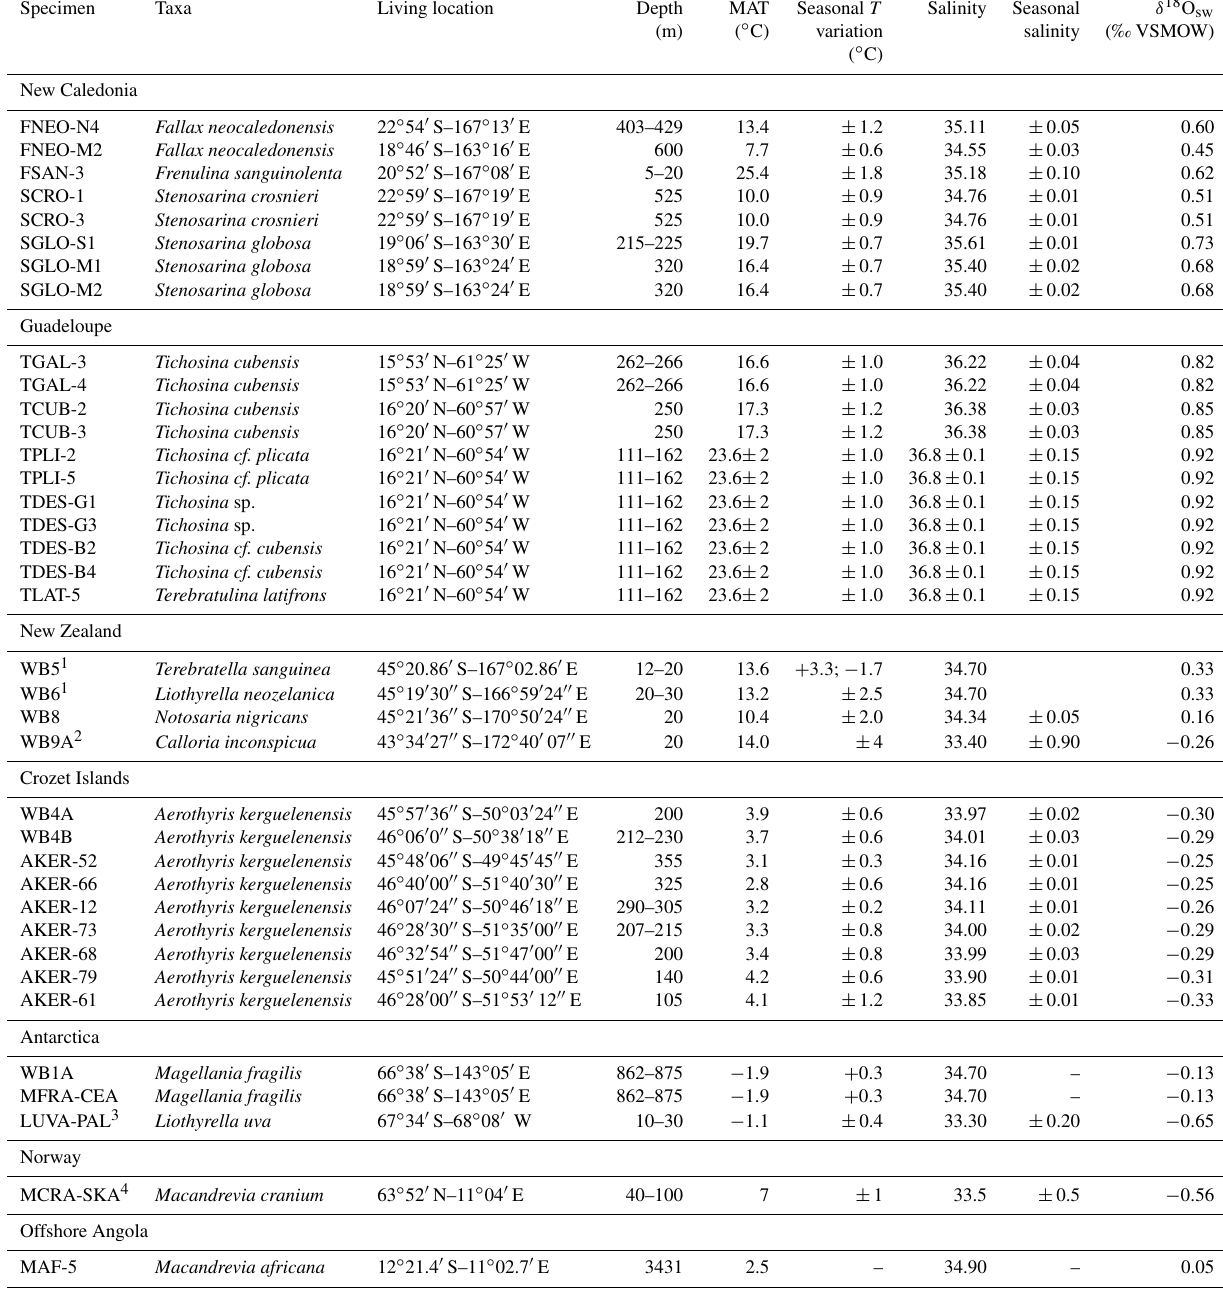
Table 1. Brachiopod samples with taxonomic identification, sampling location and environmental parameters. Most environmental parame- ters are derived from the World Ocean Atlas 2018 (Locarnini et al., 2018; Zweng et al., 2018). For a few samples, environmental parameters are derived from local literature, as listed below. Almost all δ 18 O sw values are calculated using the regional δ 18 O sw –salinity relationship published by LeGrande and Schmidt (2006), unless direct measurements covering seasonal variations were available in the